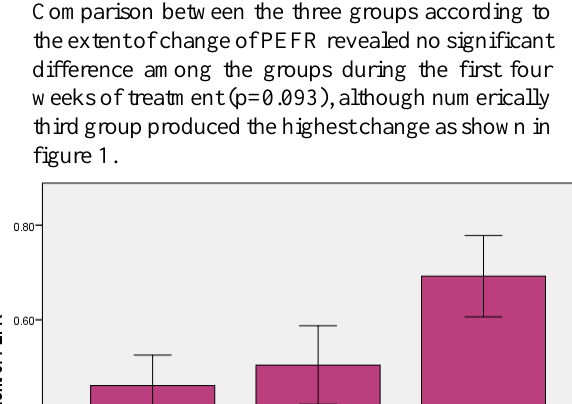
Figure 2. Comparison of groups according to extent of PEFR change during the second four weeks of study.